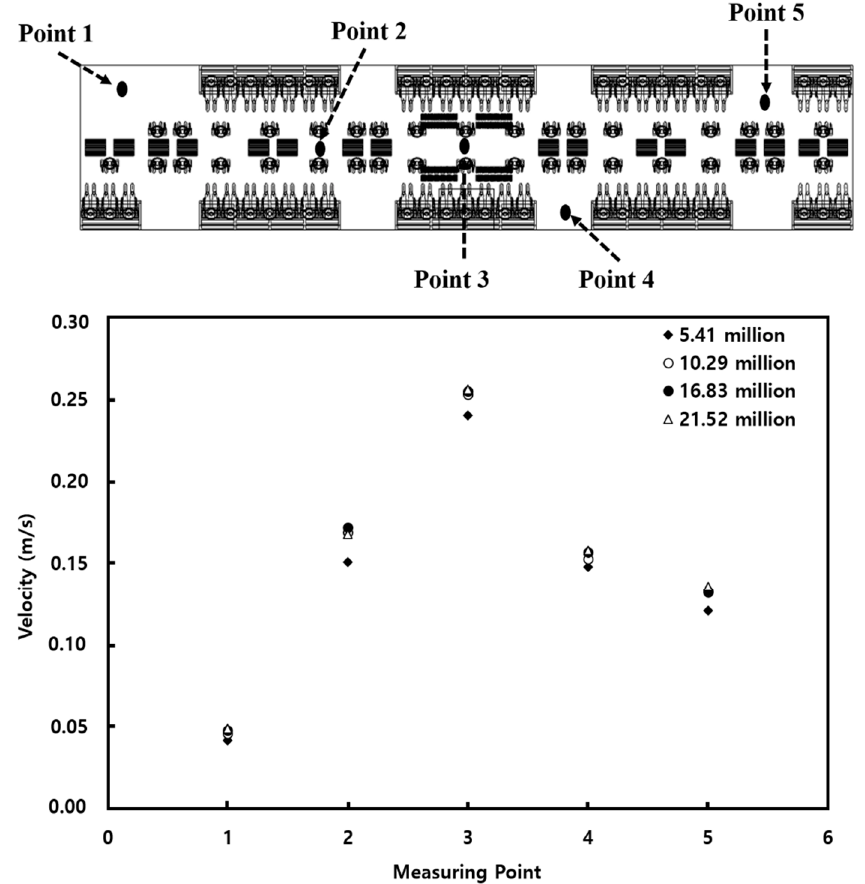
Figure 2. Grid independence test result.